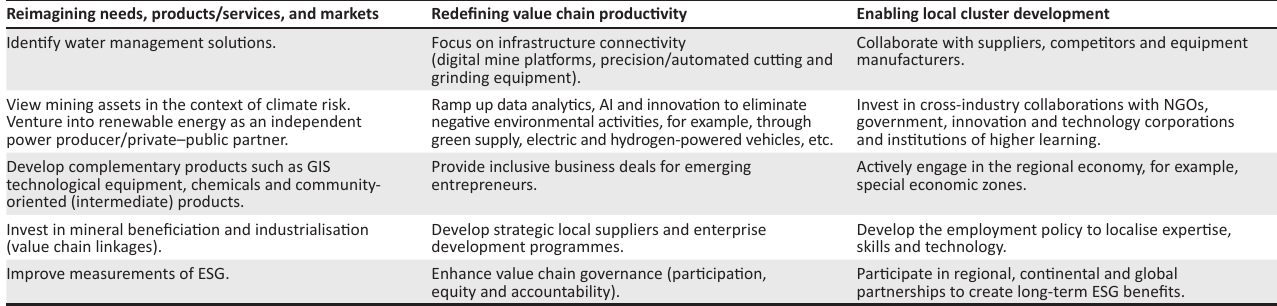
TABLE 5: Recommendations linked to Shared Value strategies in the South African mining industry. Reimagining needs, products/services, and markets Redefining value chain productivity Enabling local cluster development Identify water management